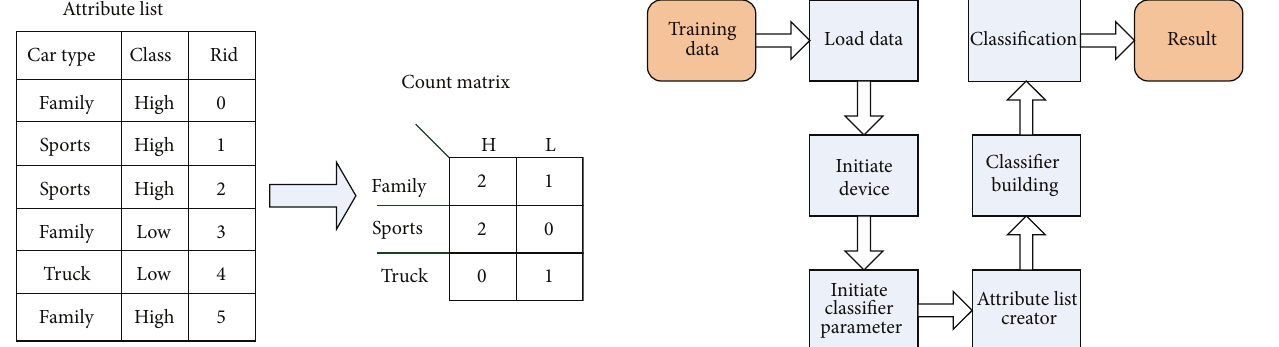
Figure 5: Count matrix of SPRINT [14].